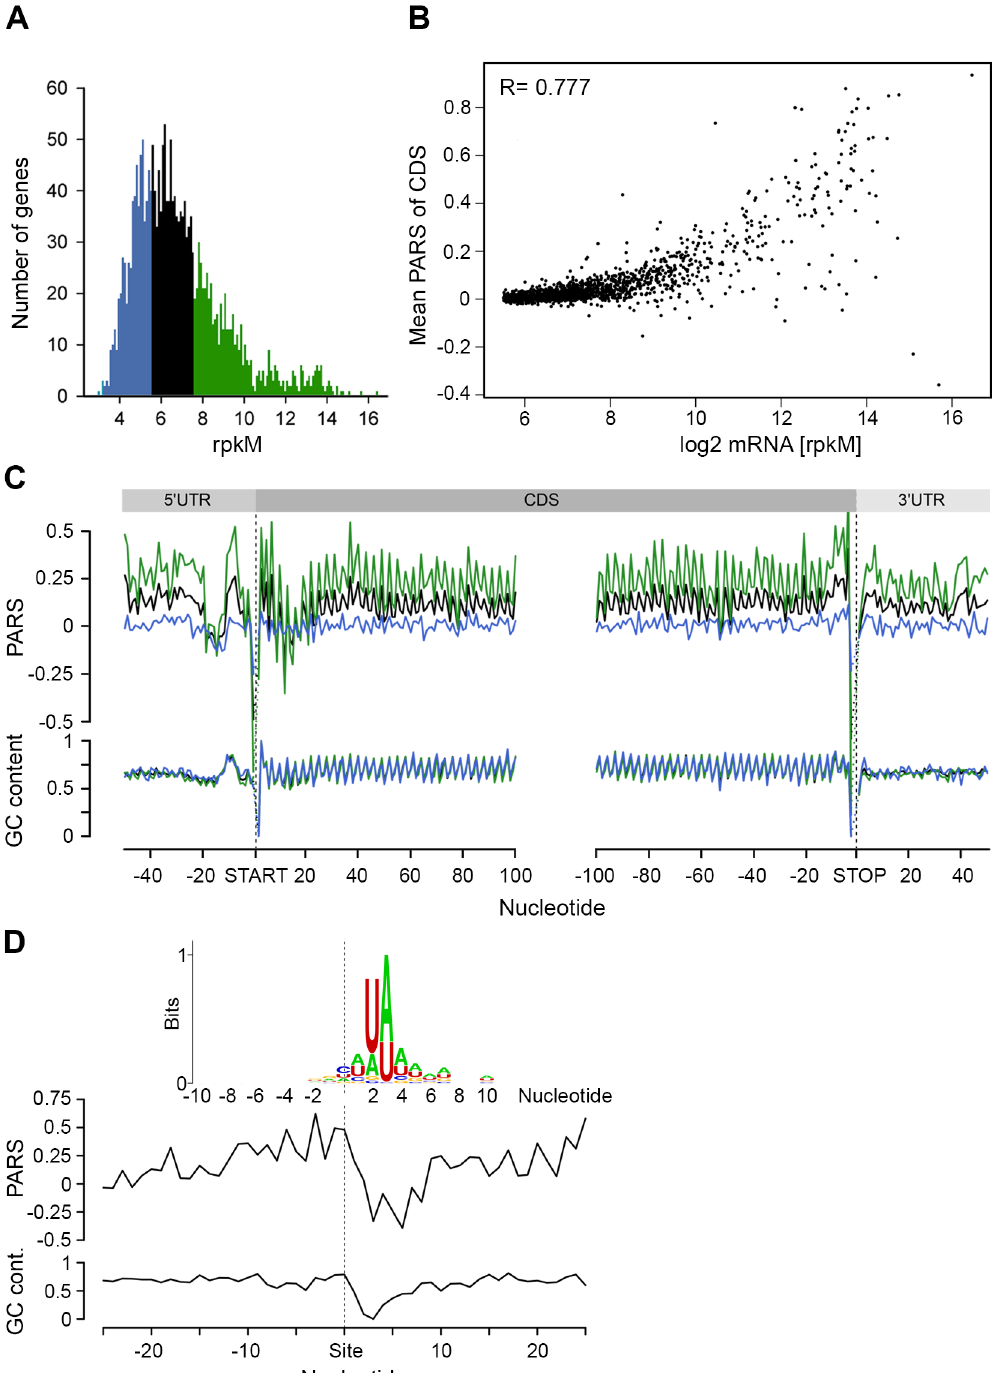
Fig 3. mRNA structure correlates with mRNA abundance. (A) Distribution of transcript abundance, expressed in gene read counts normalized by the length of CDS per kilobase and the total mapped reads per million (rpkM). The 30% least (blue) and most (green) abundant genes from the reliably detected genes (S4 Fig) are highlighted. (B) Dependence of the mean PARS score on the mRNA abundance of the middle (black) and most (green) abundant transcripts as defined in panel A. R = 0.777, Pearson correlation coefficient. (C) Average PARS score (top) and GC content (bottom) for each position of all transcripts (black curve) as well as the 30% most (green) and least (blue) abundant. (D) Average PARS score (top) and GC content (bottom) for each position around the top 64 RNase E cleavage sites (S2 Table). Inset, the sequence logo of the aligned RNase E cleavage sites, spanning from -10 to +10 nt.